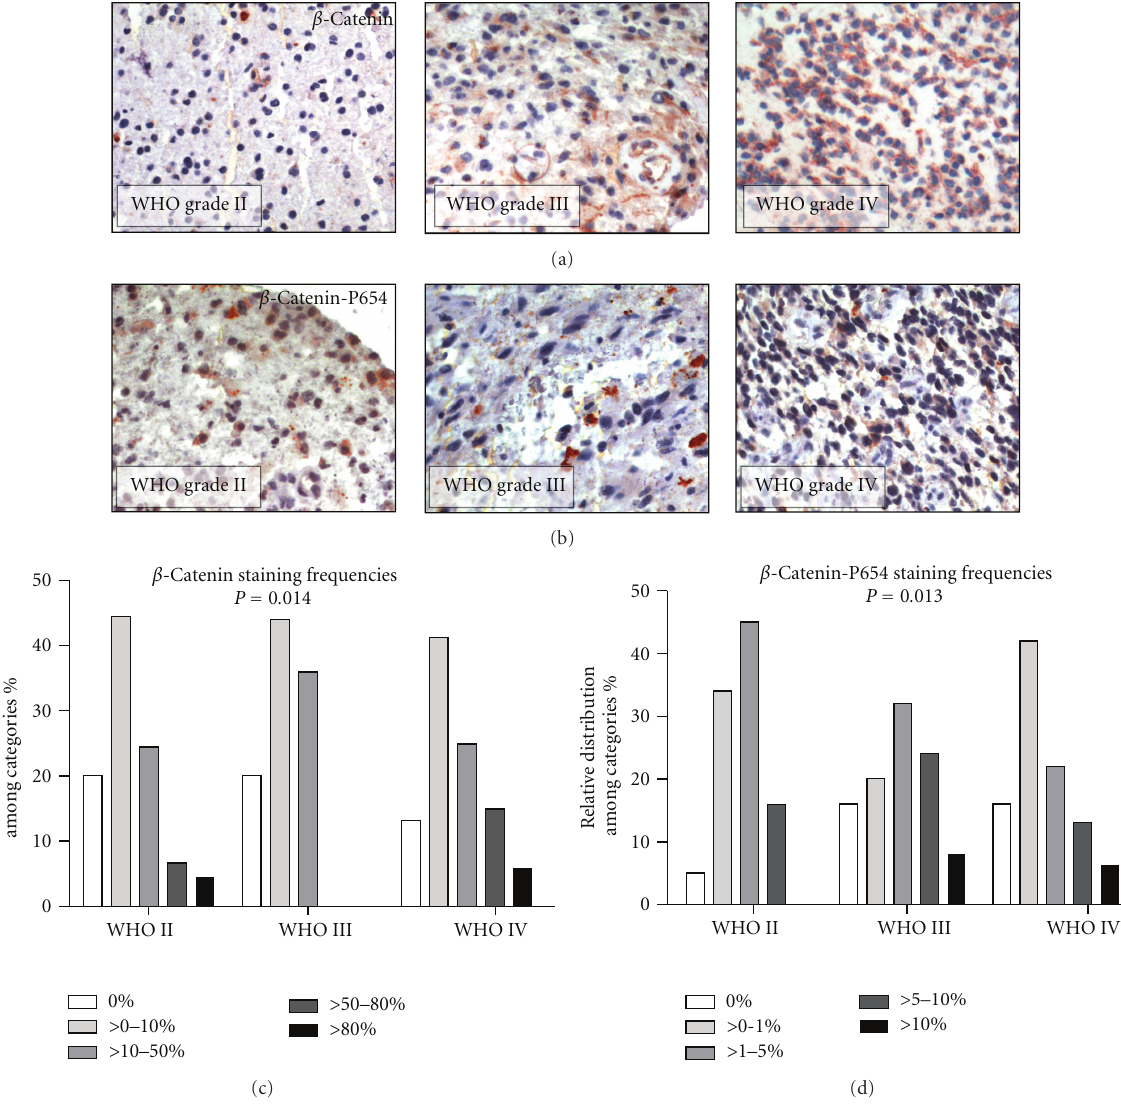
Figure 3: (a and b) Immunoreactivity of β -catenin (upper row) and β -catenin-P654 (lower row) in astrocytic gliomas of WHO grade II (left), WHO grade III (middle), and WHO grade IV (right). Scale bars represent 100 μ m. (c and d) Note that β -catenin immunoreactivity was significantly augmented with increasing WHO grade (c) while β -catenin-P654 expression significantly decreased in high-grade tumours (d). Columns indicate categories of staining